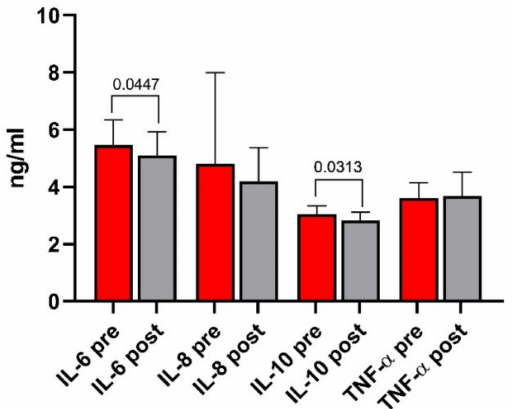
Figure 7. Circulating levels of IL-6, IL-8, IL-10, and TNF- α before and after low FODMAPs diet. Data are presented as mean ± SD. Statistical analysis: Wilcoxon matched-pairs signed-rank test with a significant difference set at p <